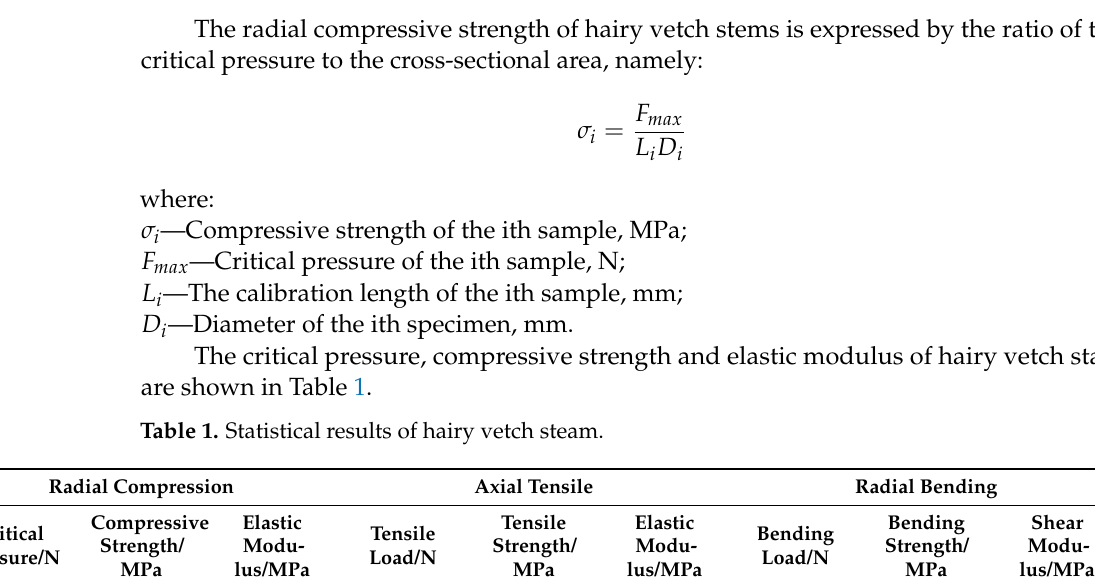
Figure 4. Compression curve of hairy vetch stalk.